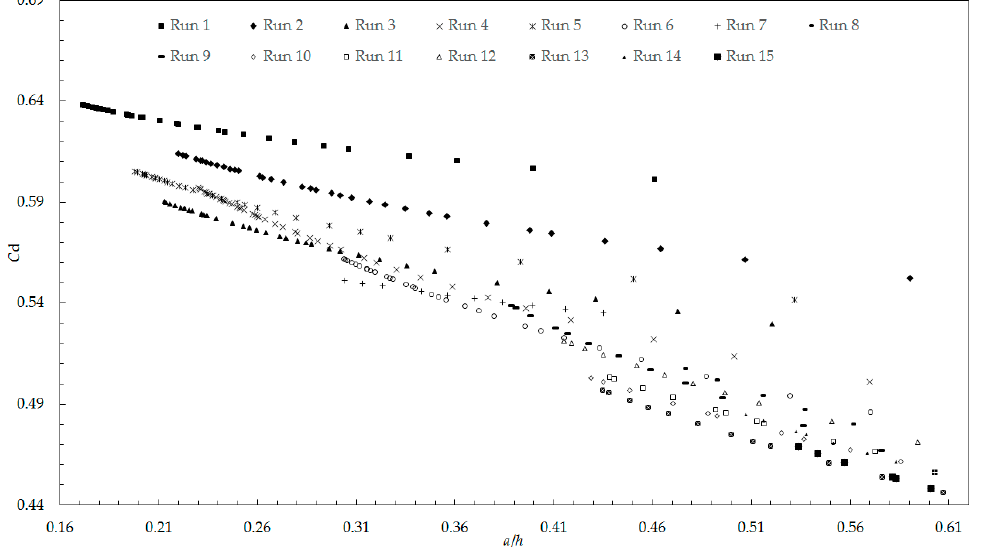
Figure 4. Discharge coefficients (C d ) versus a/h , Series 1.